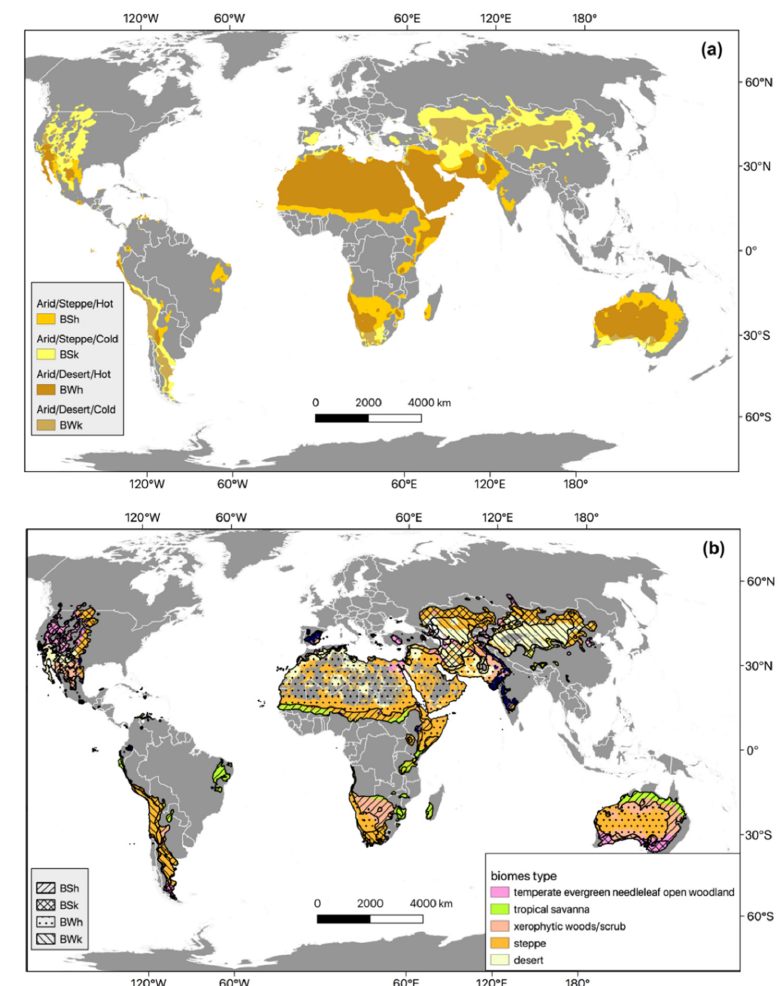
Figure 1. ( a ) Global arid regions in Köppen–Geiger climate classification, including four arid types: BSh (hot semi-arid climate), BSk (cold semi-arid climate), BWh (hot desert climate) and BWk (cold desert climate); ( b ) biomes types distribution map over the global arid